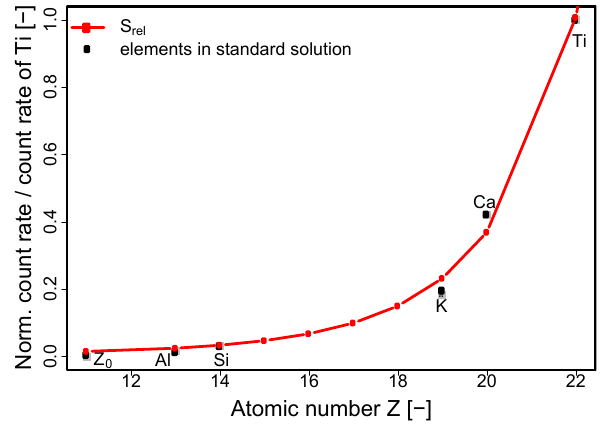
Fig. 9. Relative calibration curve S rel of K α lines for measurements at SLS: count rates are normalized to detector dead time and plotted relative to the count rate of Ti, blank values are always subtracted. An exponential fit was applied to the data and shows the extrapo- lated relative calibration curve S rel for all elements in the sample. The lower end of the detector efficiency is depicted by Z 0 in the